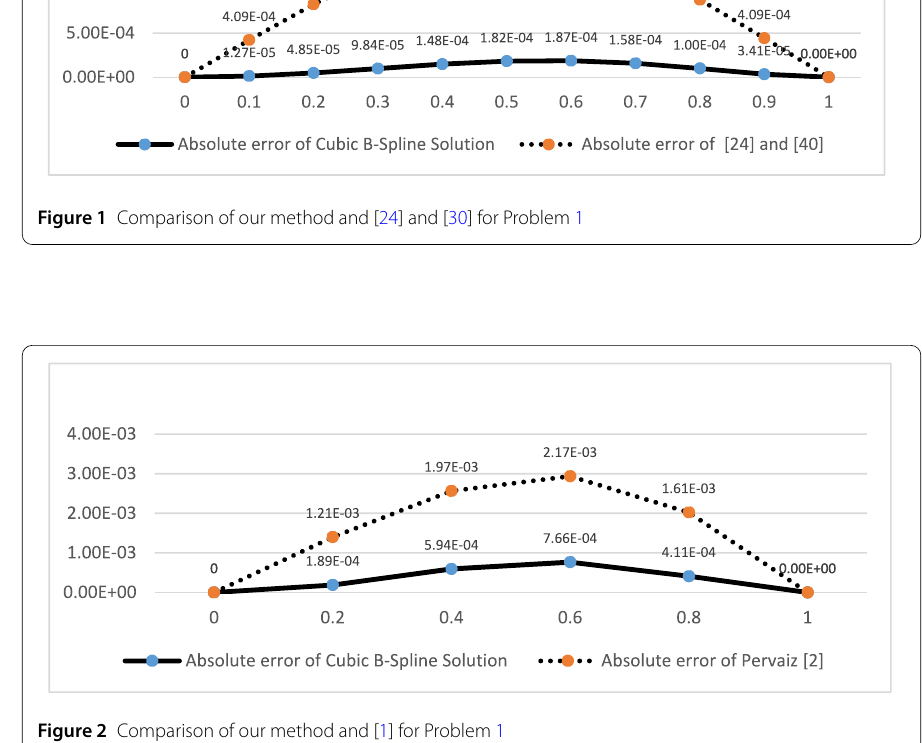
Figure 2 Comparison of our method and [1] for Problem 1